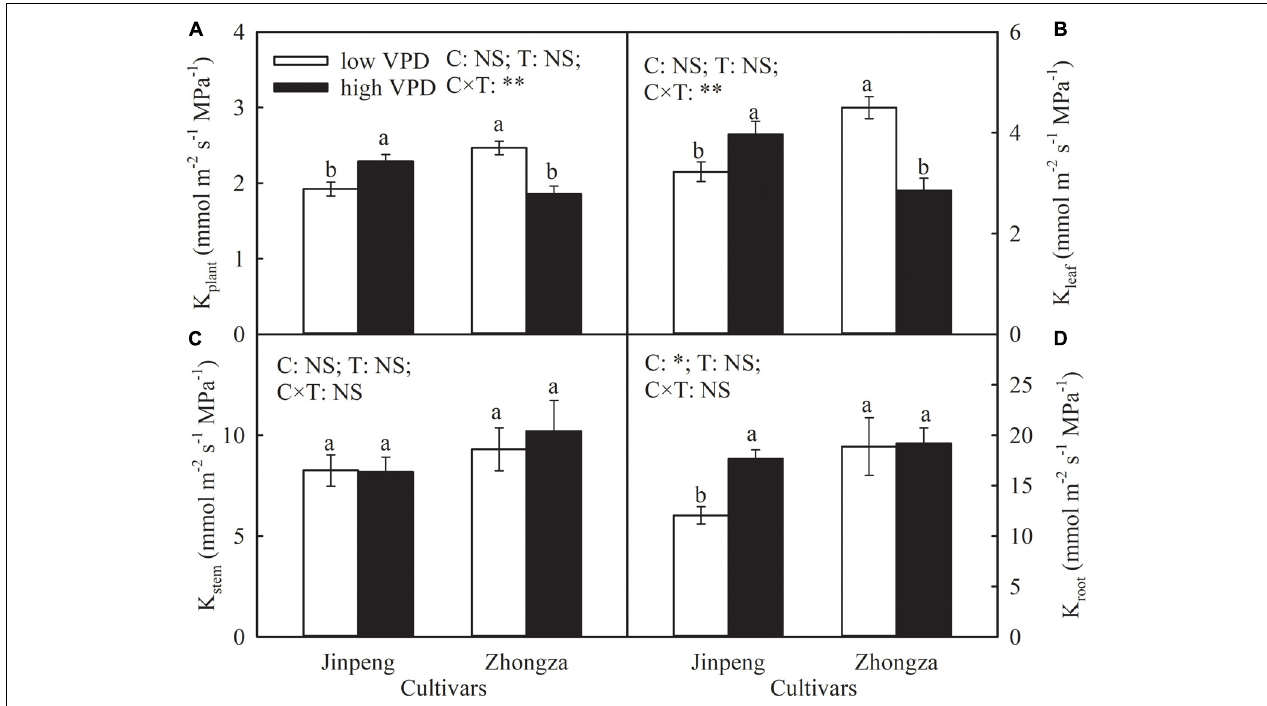
FIGURE 2 | Hydraulic conductance of whole plant (K plant ) (A) , leaf (K leaf ) (B) , stem (K stem ) (C) , and root (K root ) (D) for two tomato cultivars, Jinpeng and Zhongza, grown under low (1.1–1.5 kPa) and high (2.2–2.6 kPa) VPD. Data are means ± standard error ( n = 5 plants). Different letters denote statistically significant differences (Duncan’s test, P < 0.05). Two-way ANOVA was used to estimate the effect of cultivar (C), treatment (T), and their interaction (C × T) (** P < 0.01; * P < 0.05; NS, not significant).